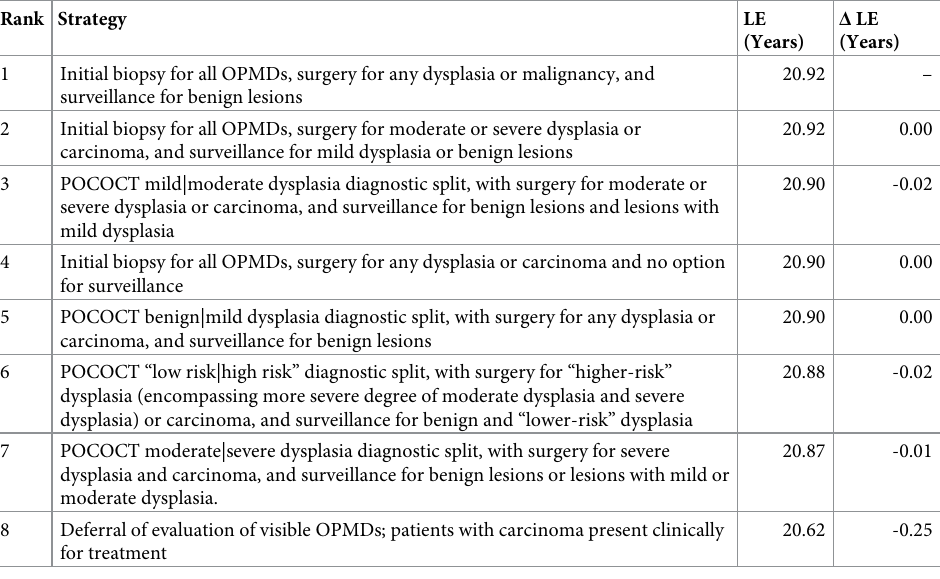
Table 3. Comparison of life expectancy using different strategies for the base case of 60-year-old men with OPMDs. Rank